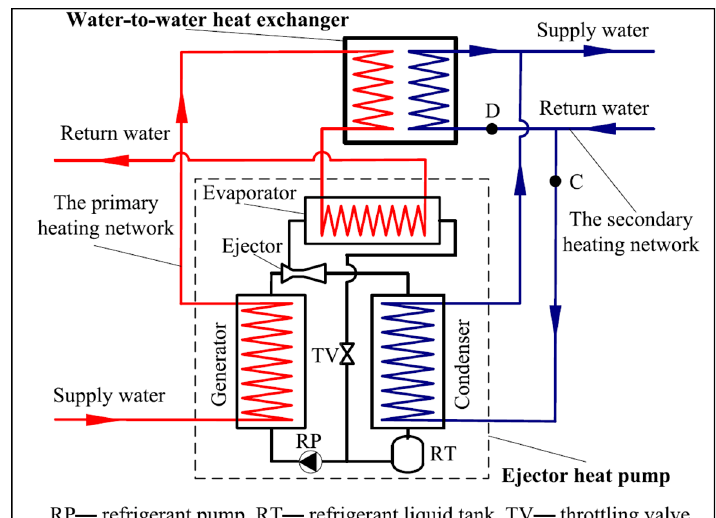
Figure 34. Ejector–combined heat and power (CHP) system [329].